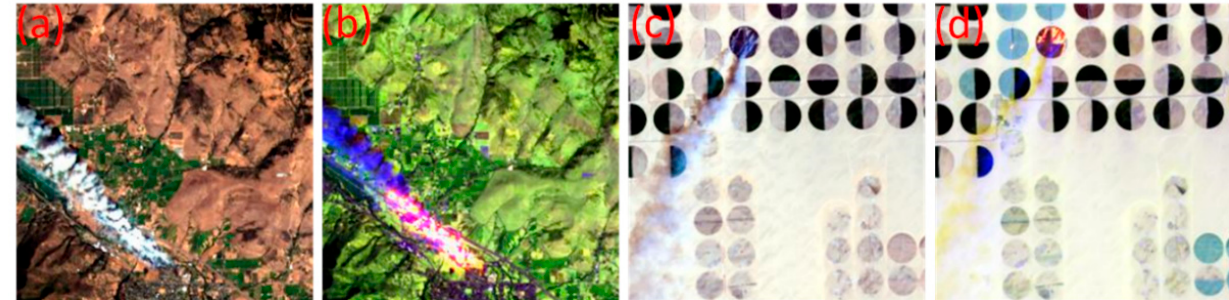
Figure 1. ( a – c ) RGB, ( b – d ) False color (SWIR2, SWIR1, and Blue) of Landsat-8 images from the reference dataset.